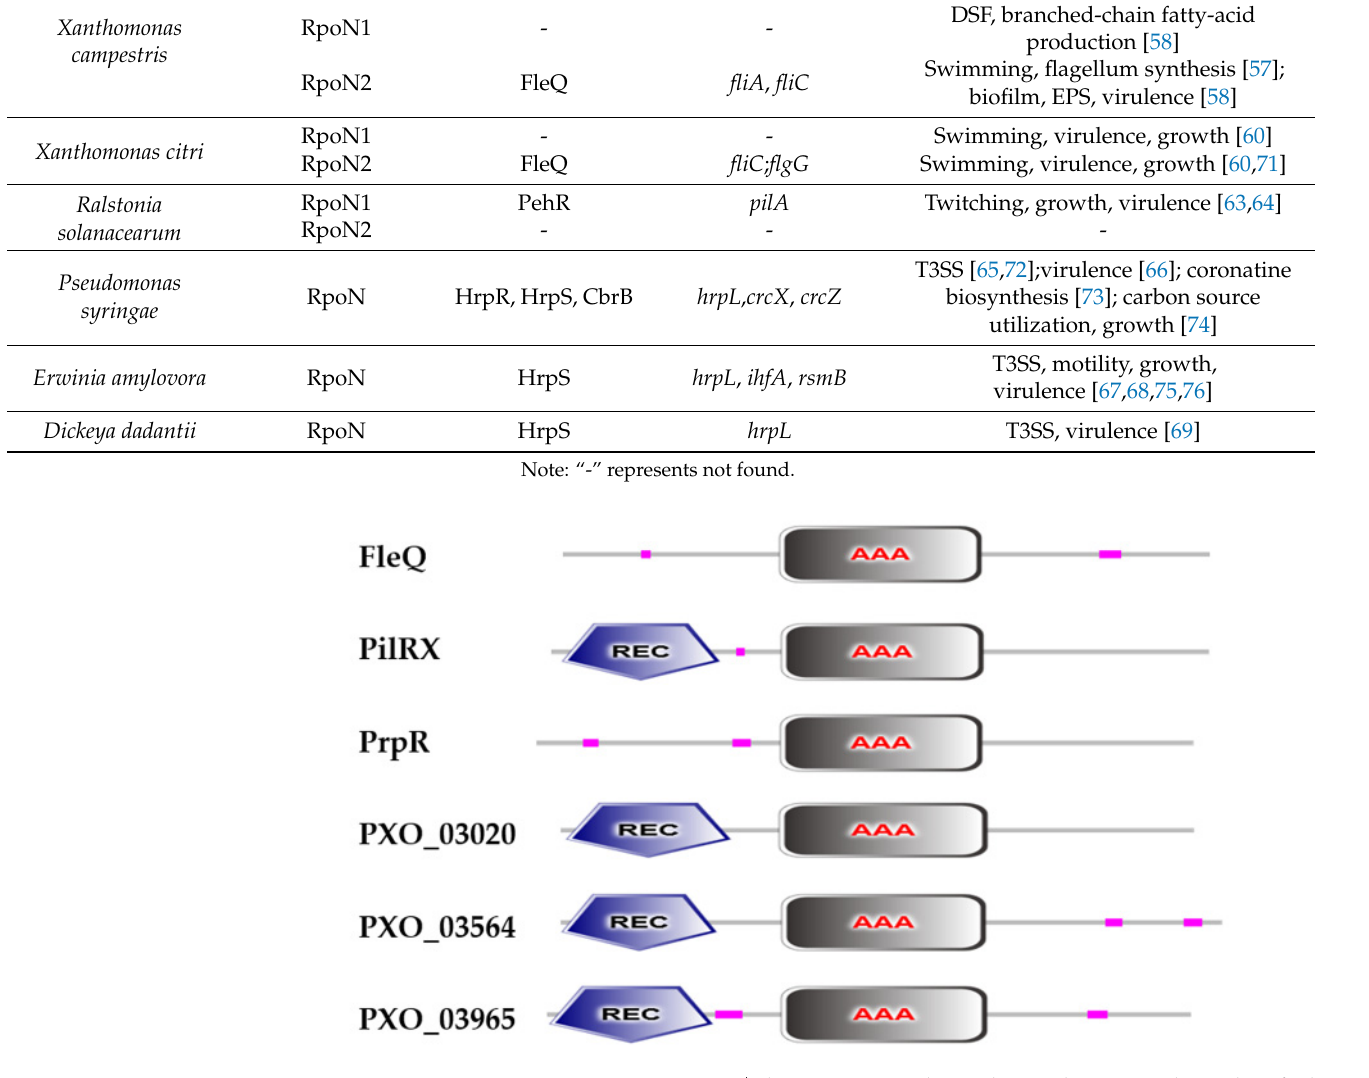
Figure 1. Six proteins containing an AAA + domain in Xoo . FleQ, PilRX and PrpR are three identified EBPs of RpoN. FleQ and PilRX interact with RpoN2 to regulate the synthesis of flagella and pili, thereby regulating swimming and twitching motility, respectively. PrpR combines with RpoN1 and RpoN2 to control Xoo growth. PXO_03020, PXO_03564, and PXO_03965 are NtrC family proteins, and their regulatory functions have not been studied in Xoo . REC, response regulator receiver do ‐ main; AAA, ATPase σ 54 ‐ interaction domain. The sequences of these proteins were downloaded from the NCBI website (https://www.ncbi.nlm.nih.gov/ (accessed on 5 May 2021)), and conserved do ‐ mains were analyzed by SMART (http://smart.embl.de/smart/set_mode.cgi?NORMAL=1 (accessed on 5 th , May, 2021)). Table 1. The RpoNs and EBPs in major phytopathogenic bacteria.